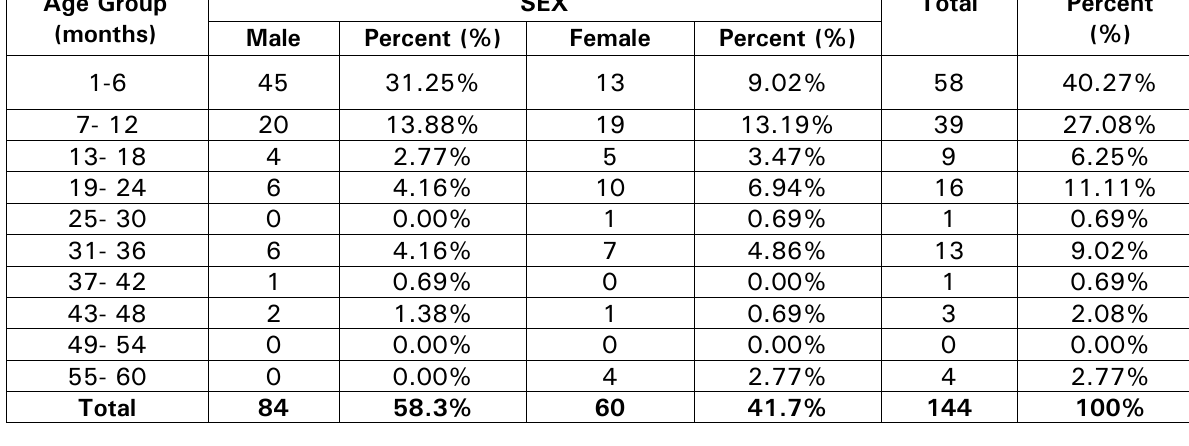
Table 1. Demographic Distribution of Severe Pneumonia Cases